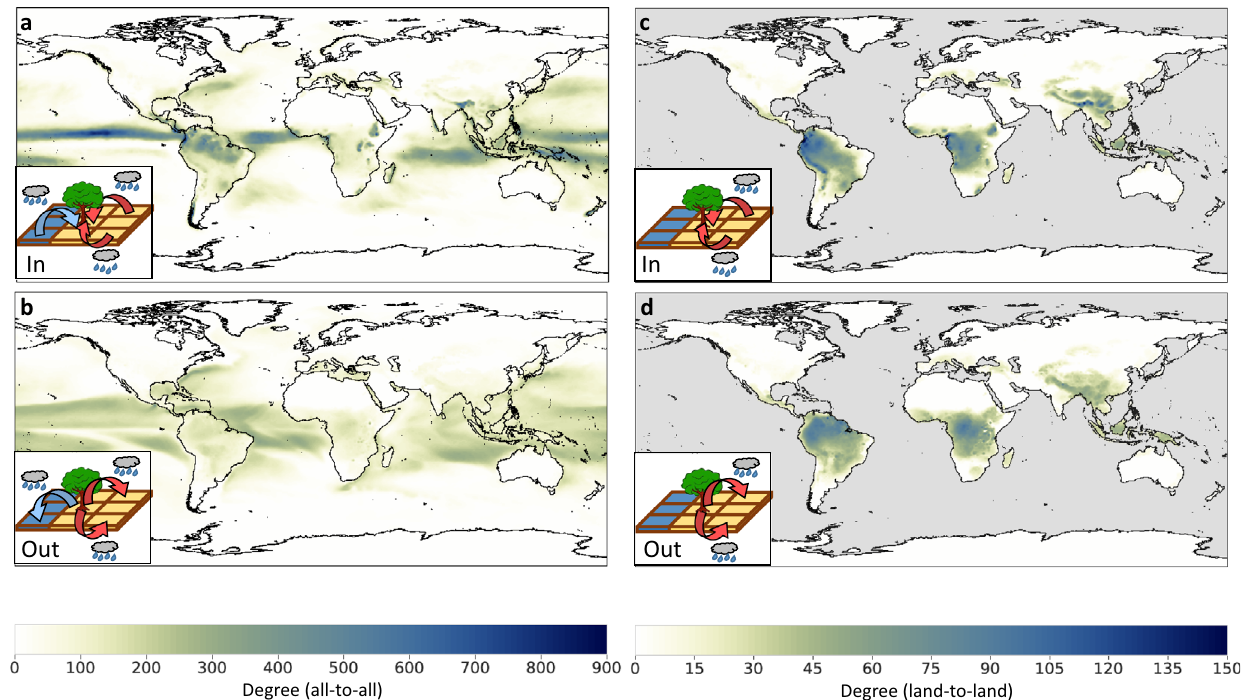
Fig. 1| In-andout-degreeoftheglobalmoisturerecyclingnetwork.a , b In-and out-degreeforallconnections,and c , d solelyforland-to-landinteractions.Highin- degree refers to nodes/grid cells receiving moisture from many other grid cells.